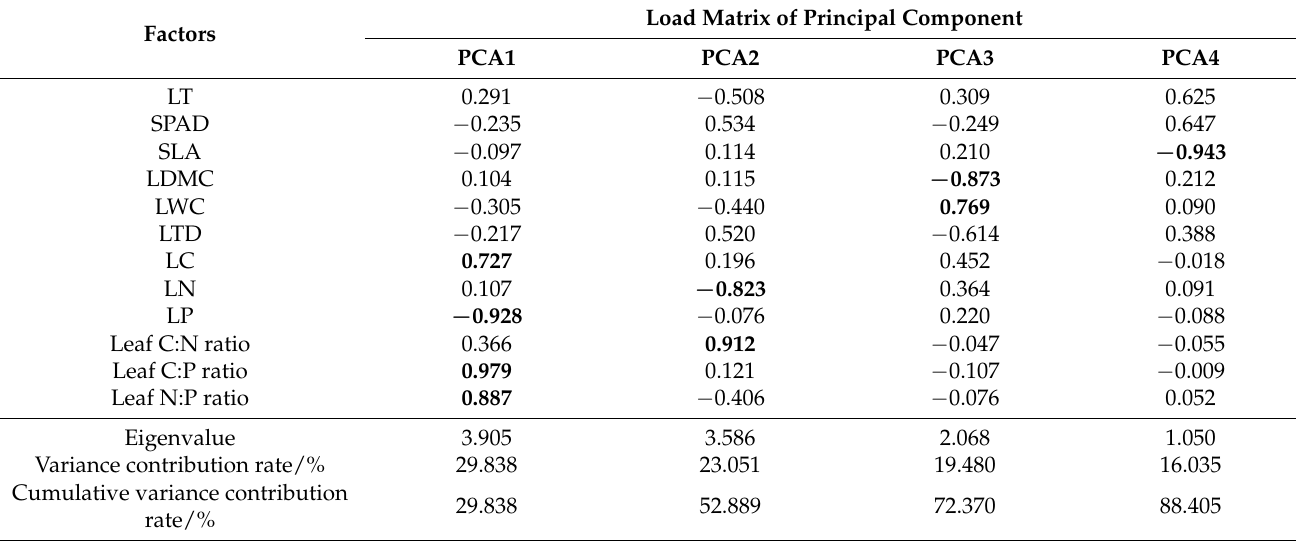
Table 5. Principal component analysis of leaf functional traits of Z. planispinum